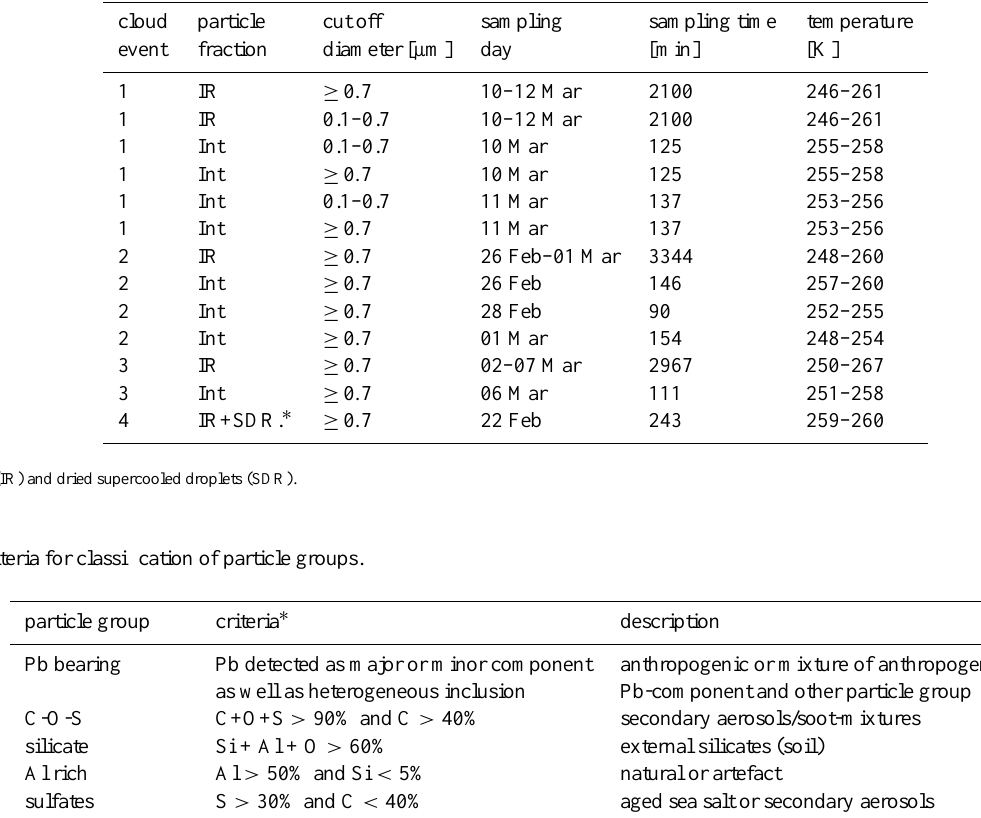
Table 1. Sampling parameters for ice residuals (IR) and interstitial samples (Int), collected during CLACE 5 within mixed phase clouds.